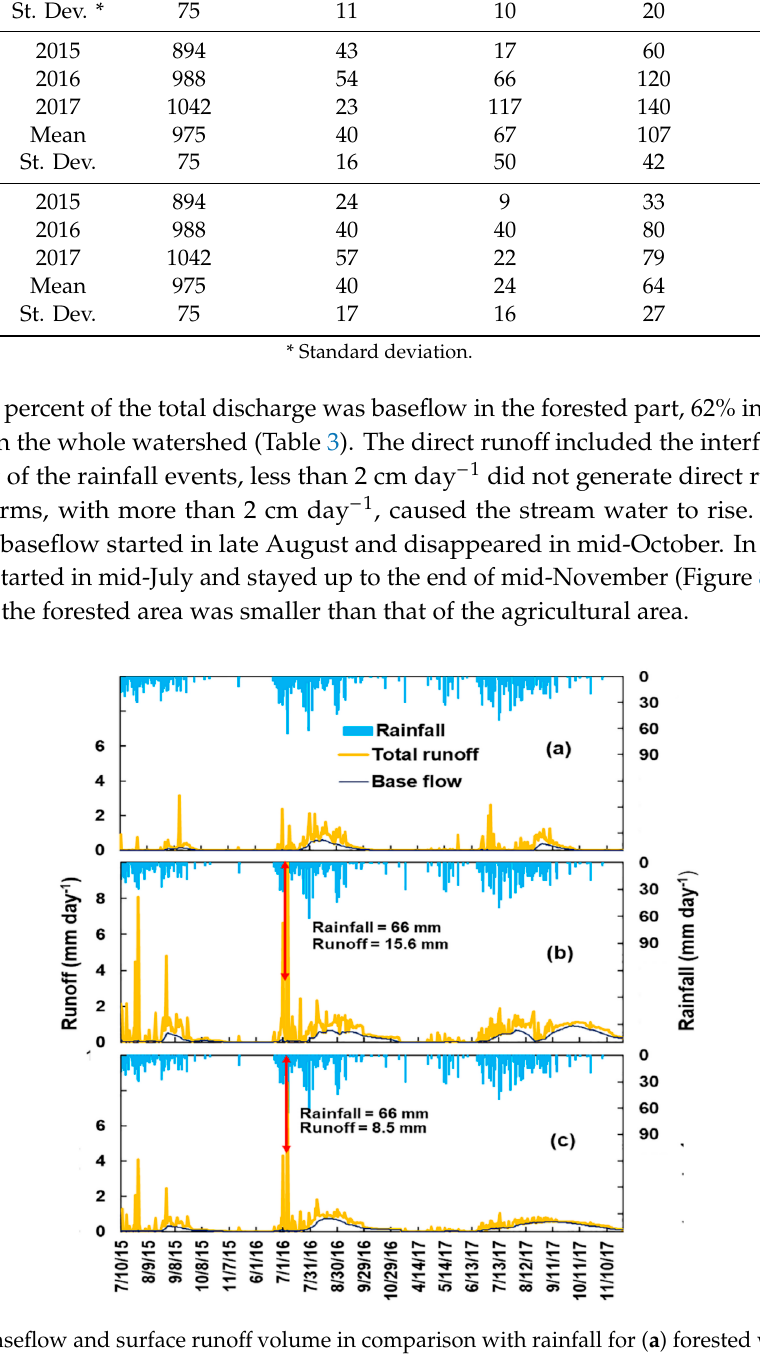
Table 3. Rainfall, direct runo ff (surface flow and interflow), baseflow, and runo ff coe ffi cient for the entire Gomit watershed, the forested watershed, and the downstream agricultural area. Rainfall Direct Runo ff Baseflow Total Runo ff Watershed. Year mm a − 1 mm a − 1 mm a − 1 2015 894 Forested